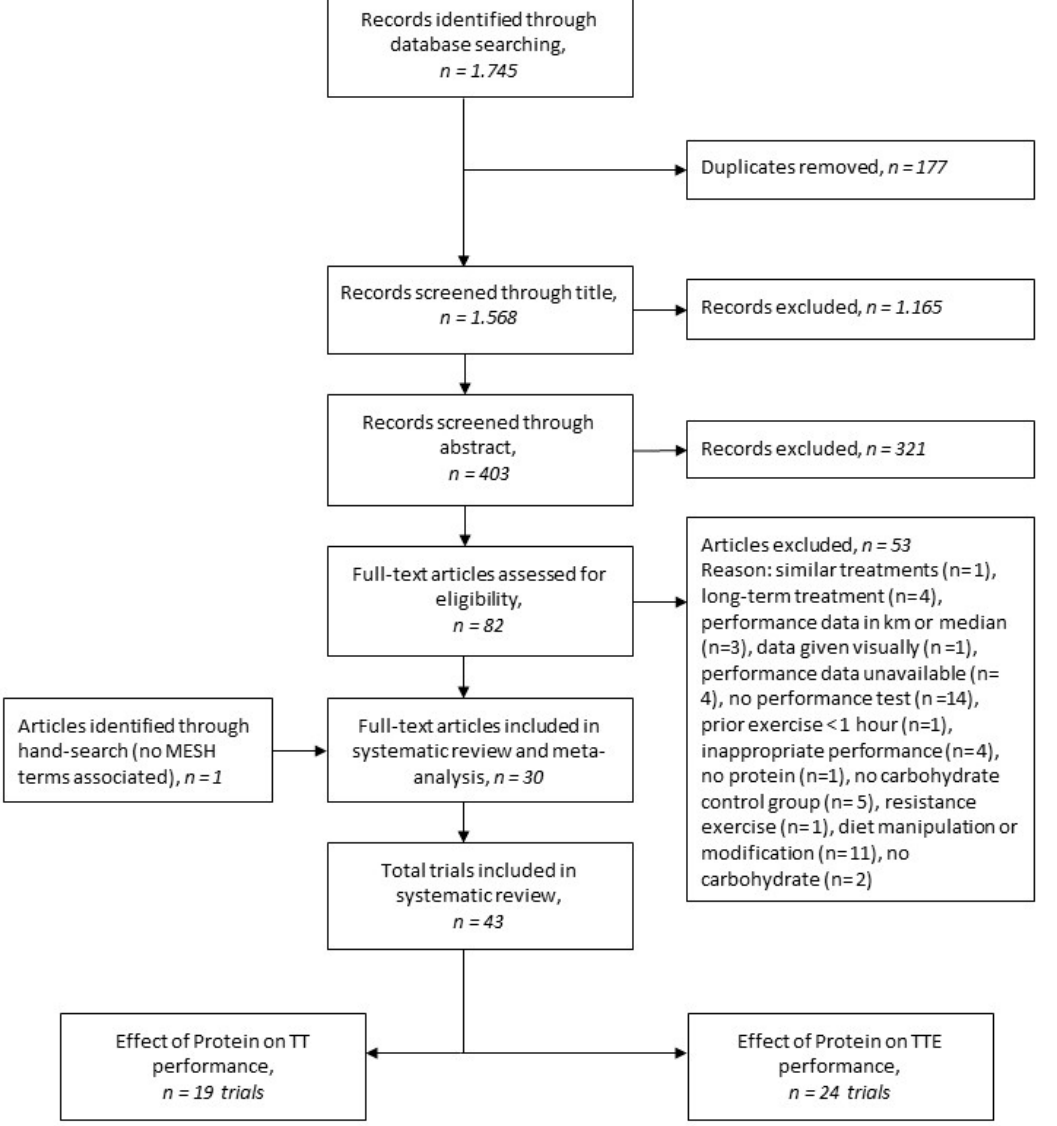
Figure 1. Flowchart presenting the number of studies screened, assessed for eligibility, and included in meta-analysis investigating the effect of carbohydrates and proteins (CHO-PRO) on Time-To- Exhaustion (TTE) and Time-Trial (TT) performance.